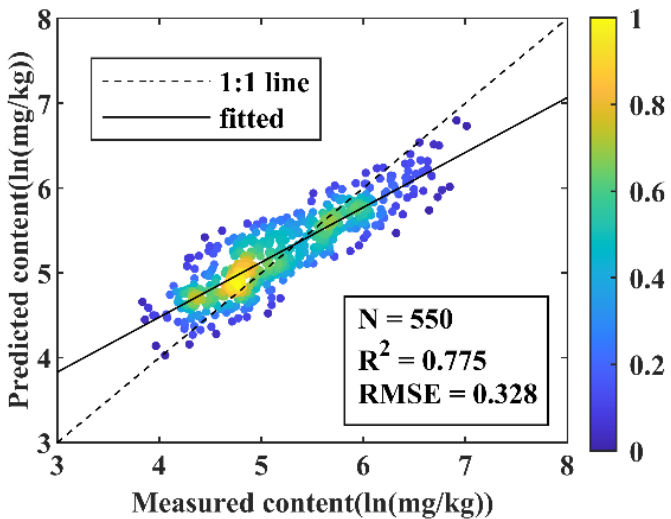
Figure 8. Scatter density diagram for 550 map pixels based on OK interpolation of measured and predicted soil Pb contamination. The density values are scaled to 0.0–1.0.